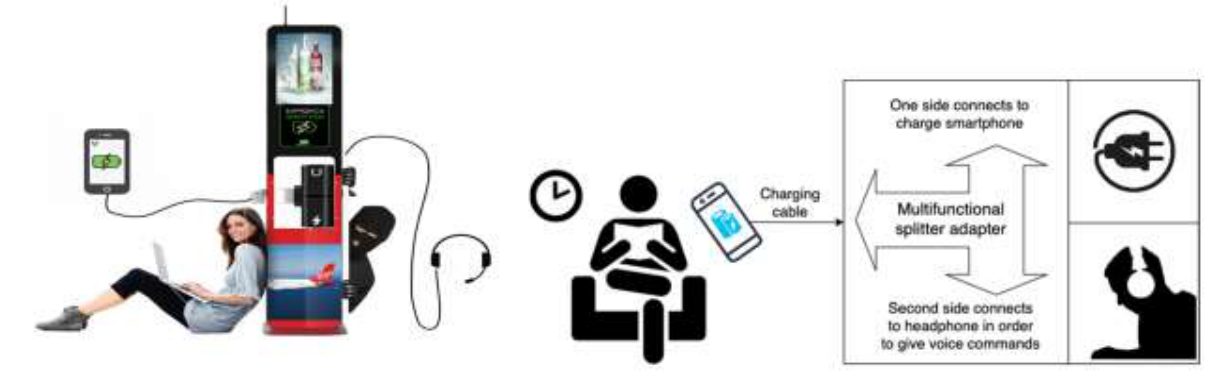
Figure 16. The Scheme of the attack.